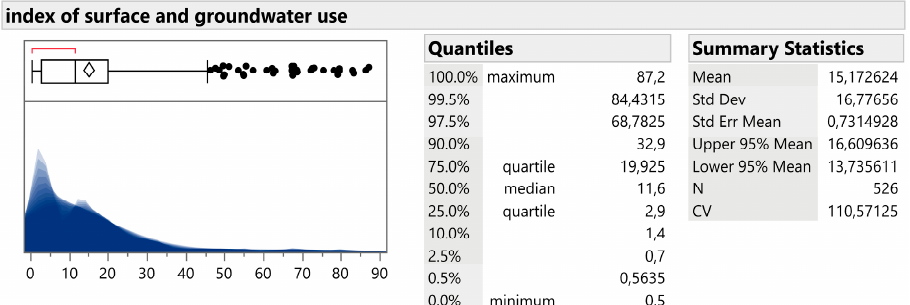
Figure 2. Distribution analysis of the index results–Index of water use in 1990–2017 in EU member states.